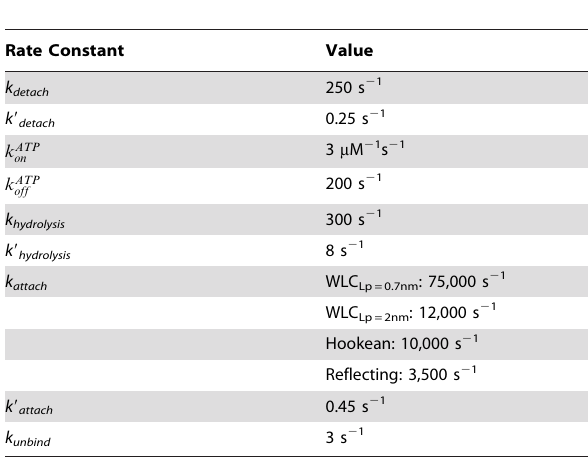
Final parameters used in the stochastic simulations of Kinesin-1 and Kinesin- 1 + DAL motors using the model shown in Figure 1. Model and rate constants were adapted from Muthukrishnan et al. [17]. The value of k attach , the attachment rate when the tethered head is within 1 nm of the binding site, depended on which neck linker model was used and was set to zero if the free head was more than 1 nm from the microtubule binding site. k 9 denotes reverse rate constants.